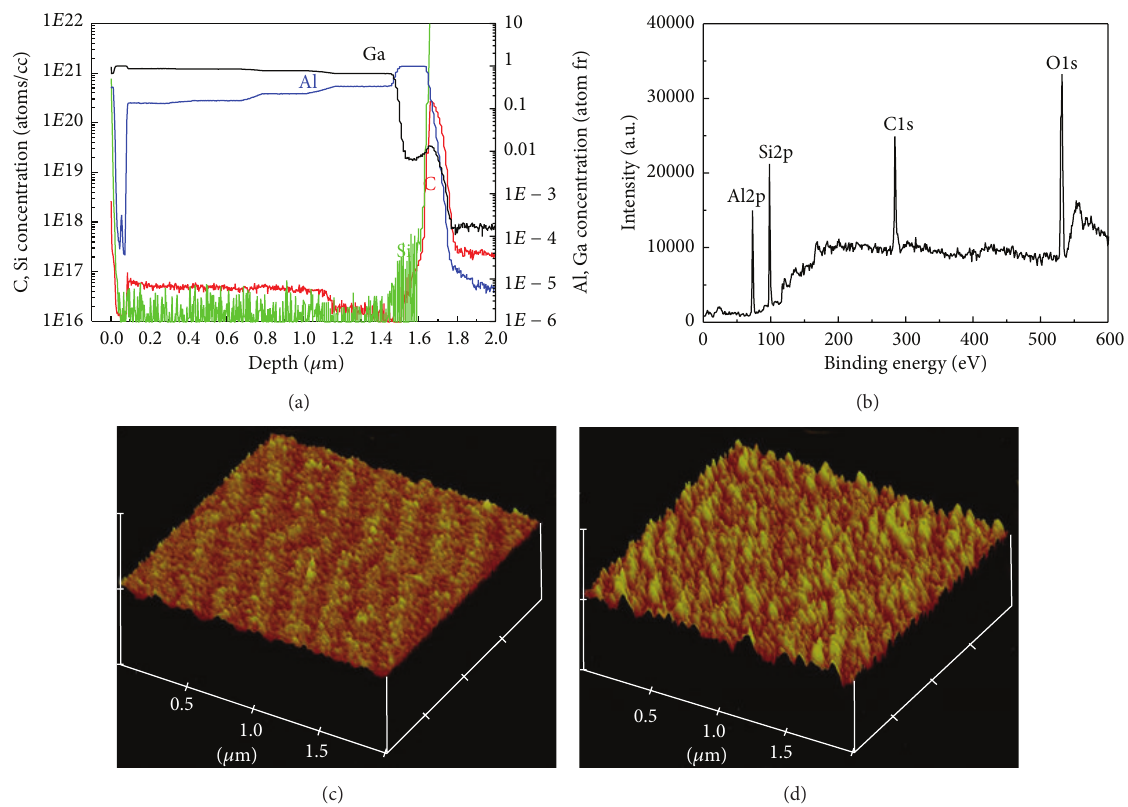
Figure 2: (a) SIMS profile of film grown on Si substrate with AlSiC precoverage layer in real epitaxial layer. (b) XPS measurement of 20 nm thick reference AlSiC film. (c) AFM images of Si surface covered with Al precoverage layer. (d) AFM images of Si surface covered with AlSiC precoverage layer.